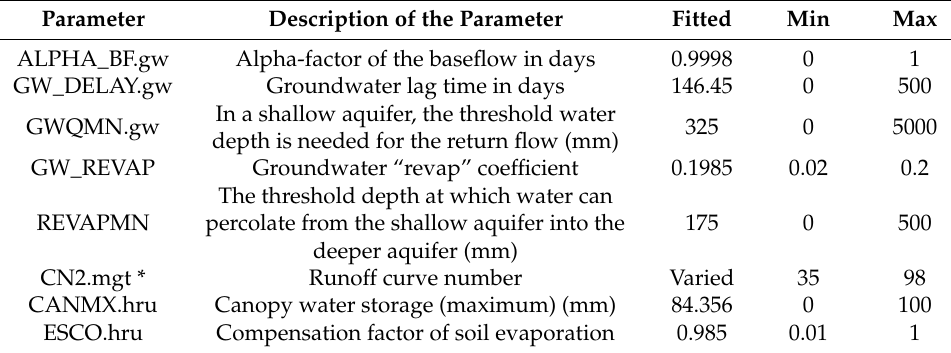
Table 5. SWAT model calibrated parameters (Hanwella sub-basin).